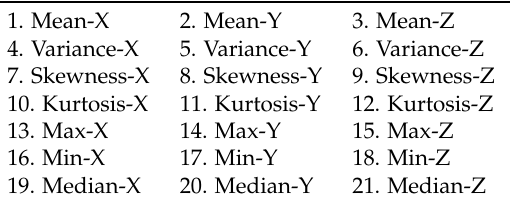
Table 1. Extracted features on the HASC and Single Chest